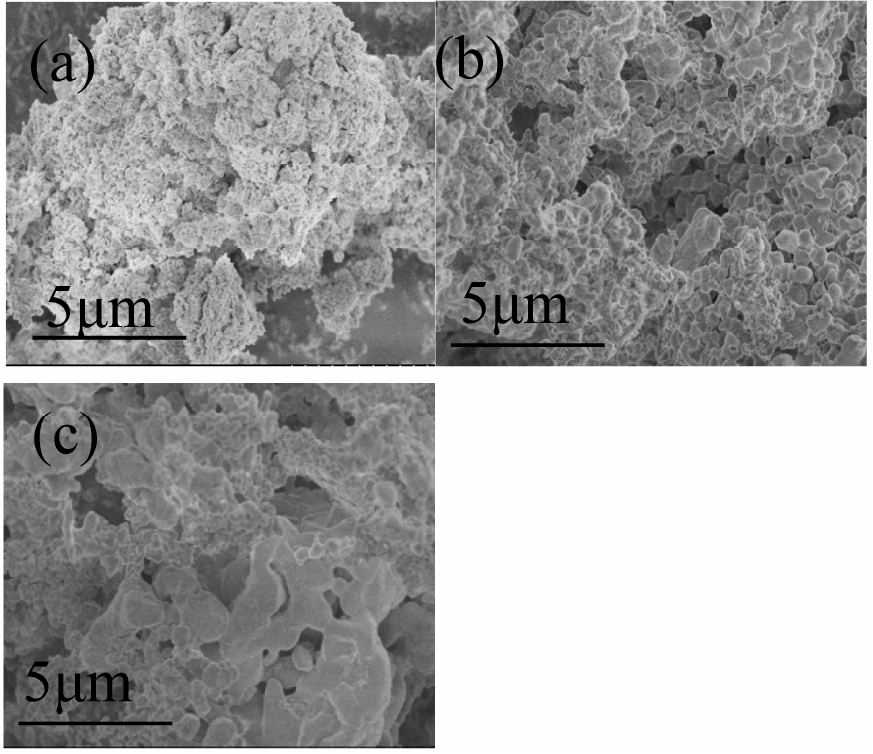
Figure 10. SEM photographs of the oxygen carriers: ( a ) fresh, ( b ) after 5 cycles, ( c ) after 20 cycles. SEM results of di ff erent added masses of alkali lignin ash and K 2 CO 3 were tested